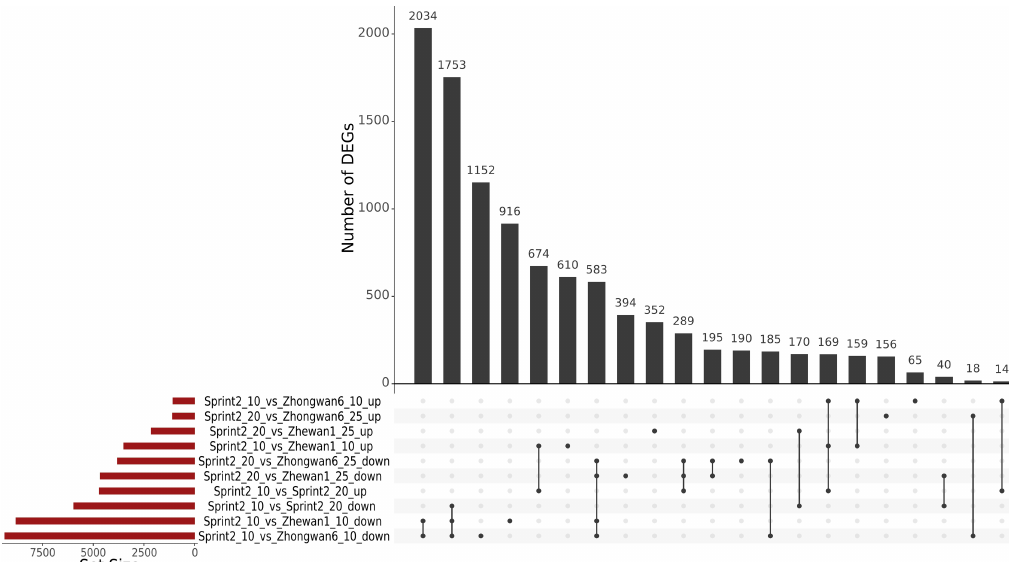
Figure 4. Numbers of di ff erentially expressed genes (DEGs) from all the comparisons involving a combined assembly. In each pair, the latter condition indicates the predictor in the respective comparisons. Plotted are unique DEGs and the most notable intersections; for the full version, see Figure